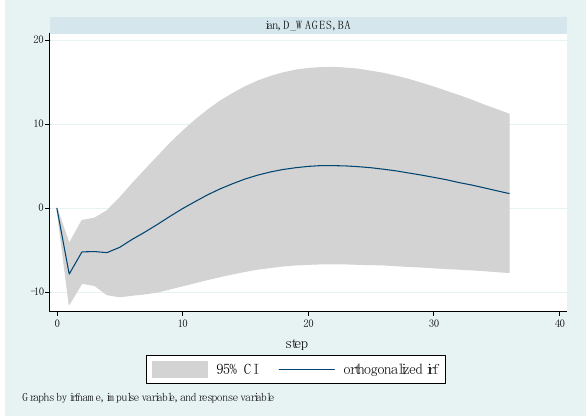
Figure 12. Impulse in the form of salary growth and a response in the form of growth of real estate prices in the Bratislava region.